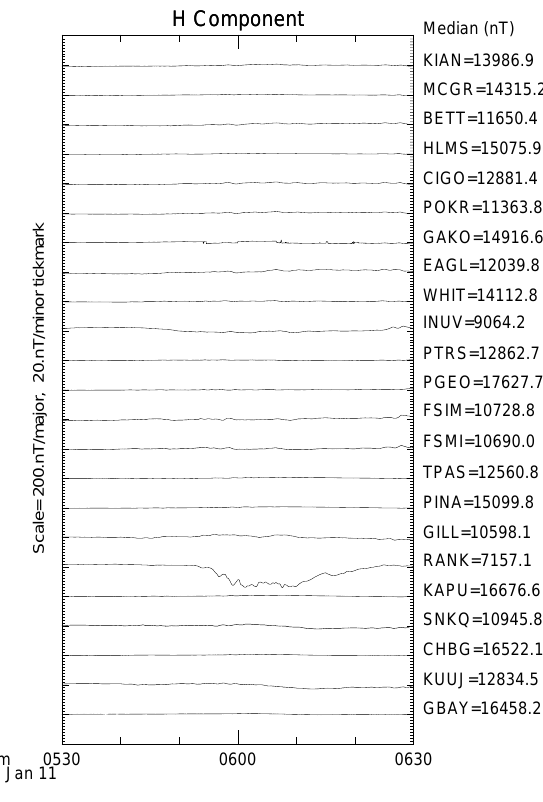
Fig. 7. H component of Themis ground magnetometer data from high latitude